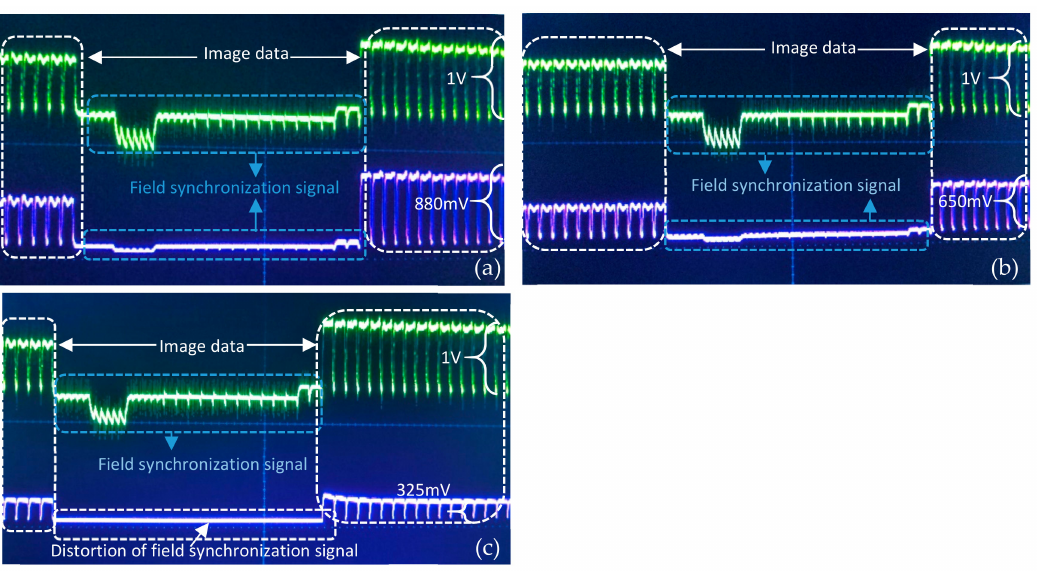
Figure 5. Waveform analysis of AISRT ( a ) waveform of first relay node, ( b ) waveform of second relay node, and ( c ) waveform of final receiver.